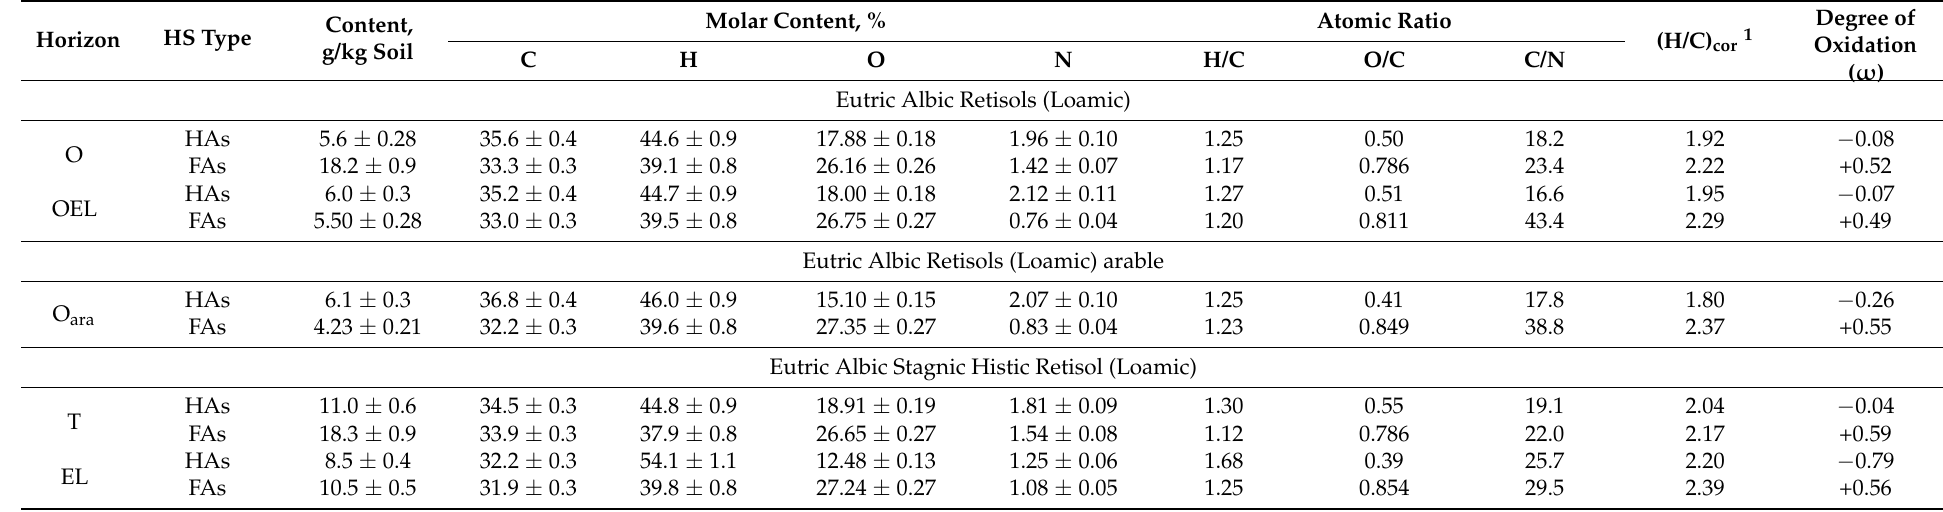
Table 3. Distribution and elemental composition of HAs and